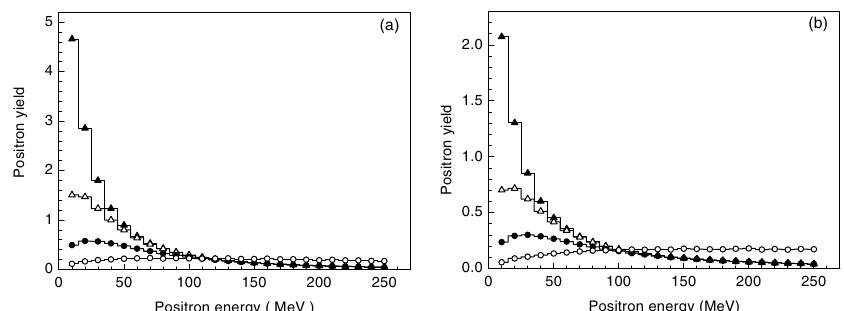
FIG. 3. Positron yield depending on energy from 9.0-mm-thick crystal (a) and amorphous (b) targets at different collimation. Filled triangles: no collimation ( # (cid:12) 24 (cid:14) ; filled circles: # (cid:12) 12 (cid:14) ; and open circles: # open triangles: # out out by 30).